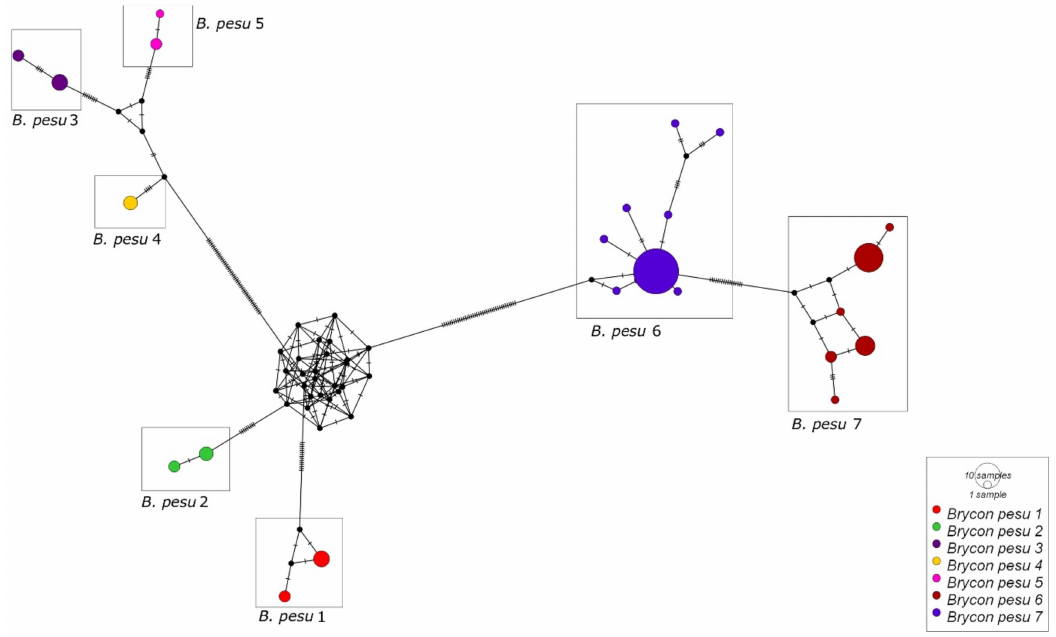
Figure 5. Haplotype network of the seven mitochondrial lineages (MOTUs) identified in Brycon pesu. Each circle represents a single haplotype and its size is proportional to its frequency.